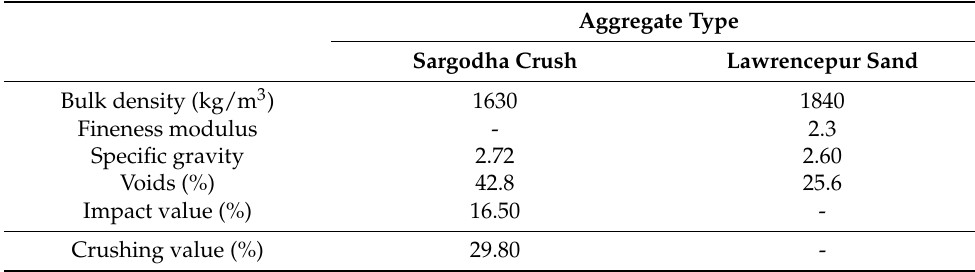
Table 1. Aggregate